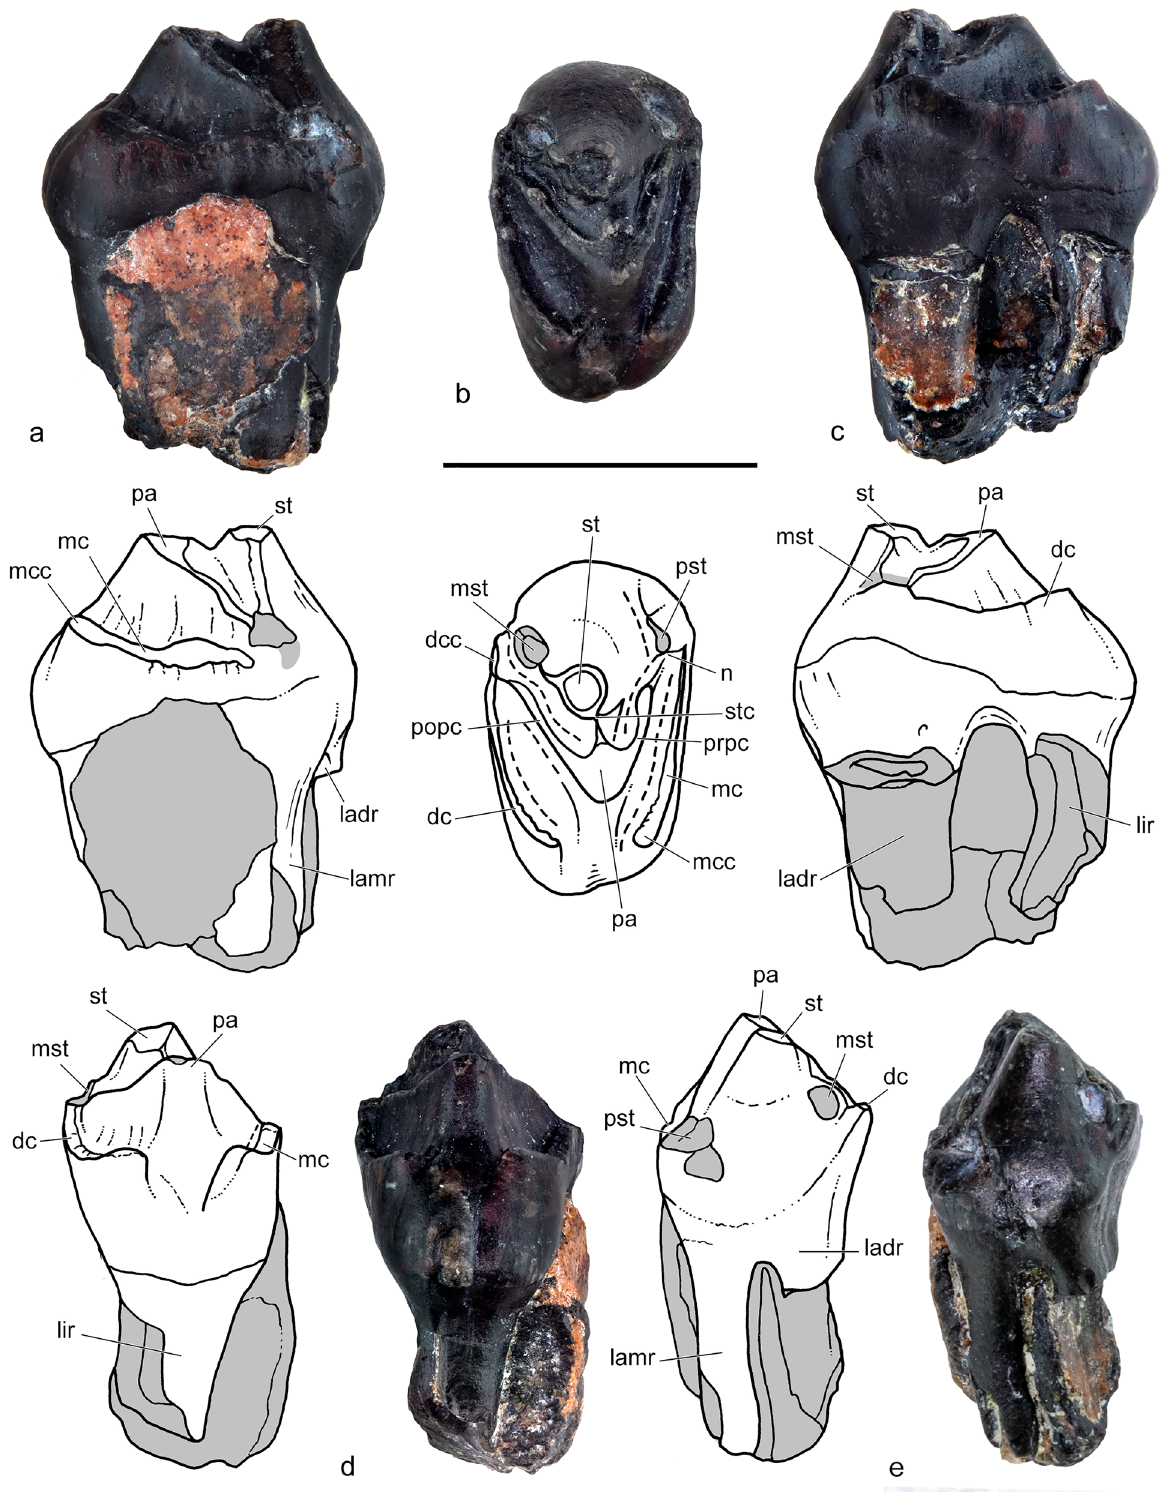
Figure 4. Orretherium tzen gen. et sp. nov. (CPAP-5008). ( a – e ) last right upper premolar (P3) in mesial ( a ), occlusal ( b ), distal ( c ), lingual ( d ) and labial ( e ) views, with accompanying line drawings. Drawings made by A.G.M. dc distal cingulum, dcc distal cingulum cusp, ladr labiodistal root, lamr labiomesial root, lir lingual root, mc mesial cingulum, mcc mesial cingular cusp, mst metastyle, n notch, pa paracone, pst parastyle, popc postparacrista; prpc, preparacrista; st, stylocone; stc, styloconar crest. Scale bar: 5